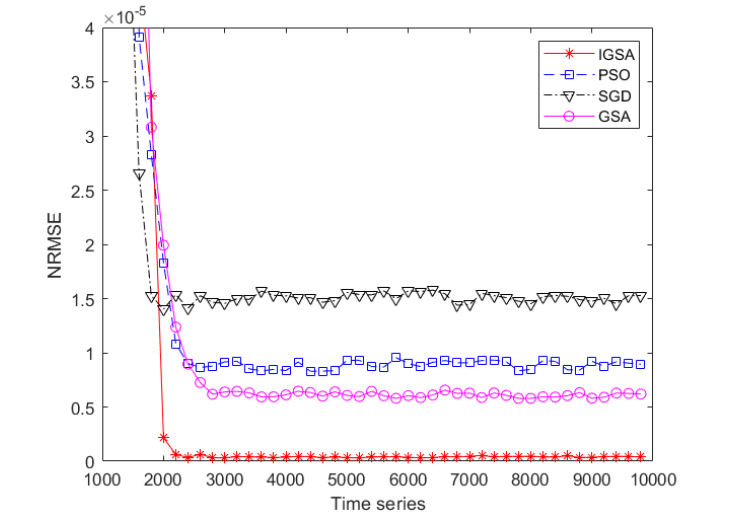
Figure 11. Training NRMSE for the sine time